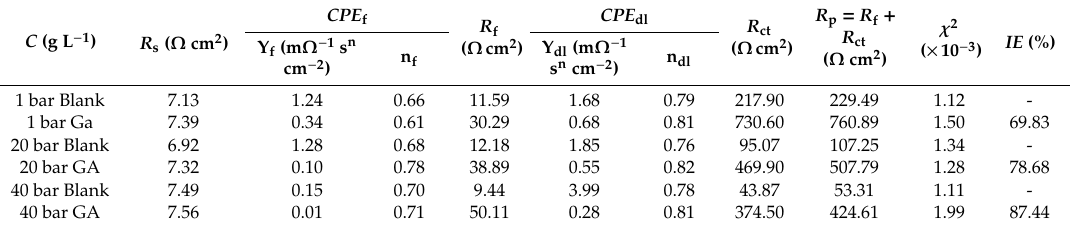
Figure 3. EIS plot recorded in the presence and absence of 1 g L − 1 of GA after 24 h of immersion at di ff erent CO 2 -partial pressures. ( a ) Nyquist; ( b ) Bode; ( c ) phase angle; ( d ) equivalent circuit Table 1. Electrochemical impedance parameters with and without the presence of 1.0 g L − 1 concentrations of GA after 24 h of immersion.